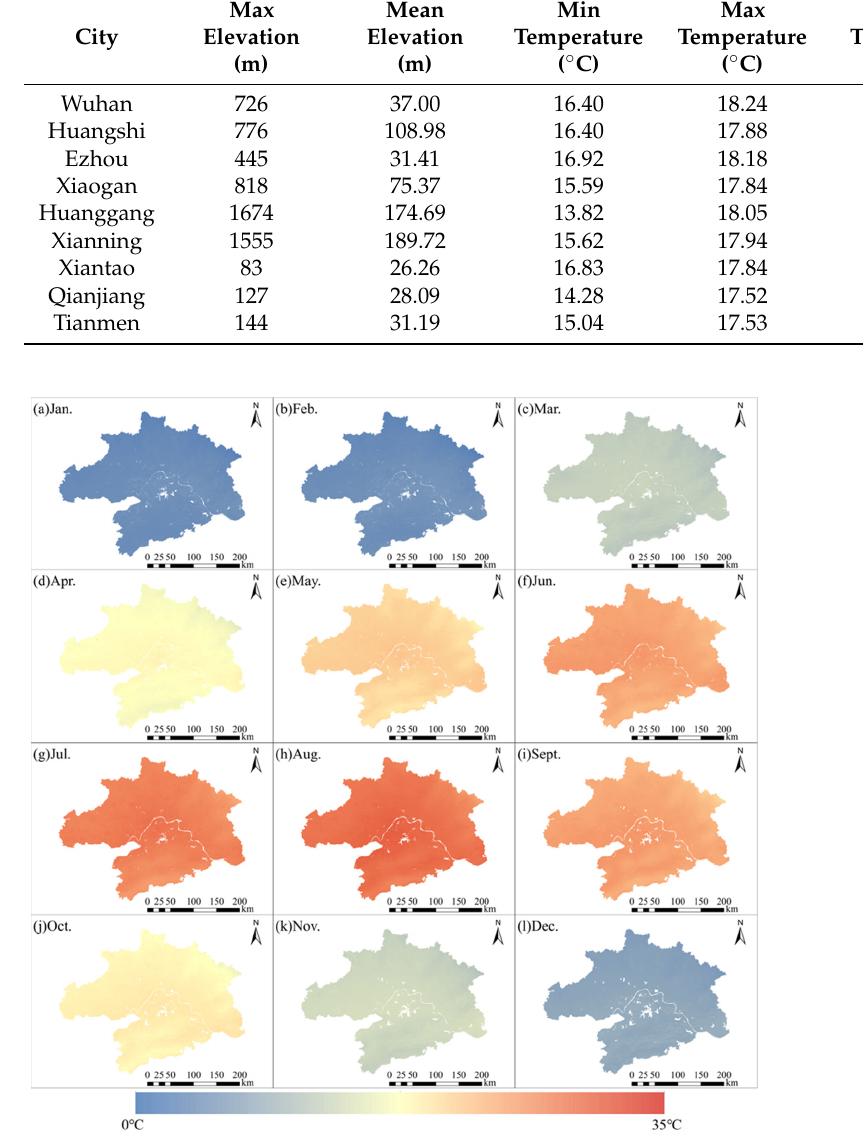
Figure 9. The spatial distributions of average fusion temperature during each season in 2019.